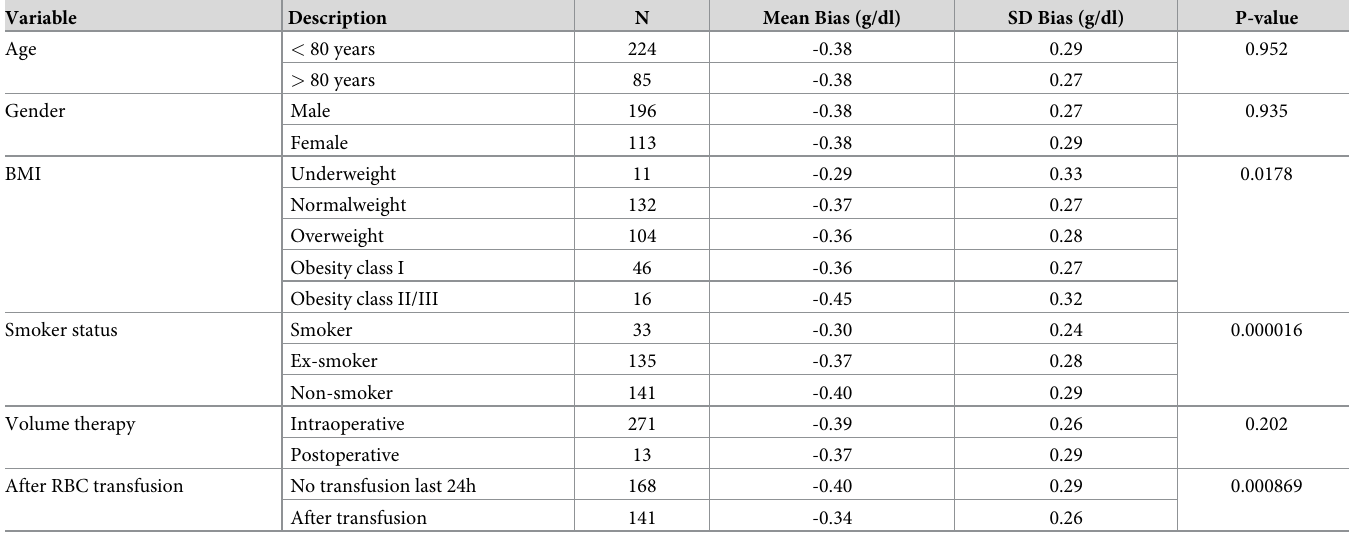
Table 1. Possible confounding factors N = absolute number of patients, SD = standard deviation (LIB-07 and LIB-26).